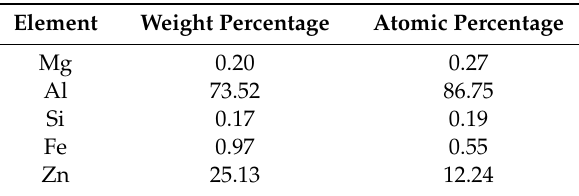
Table 5. Composition of α